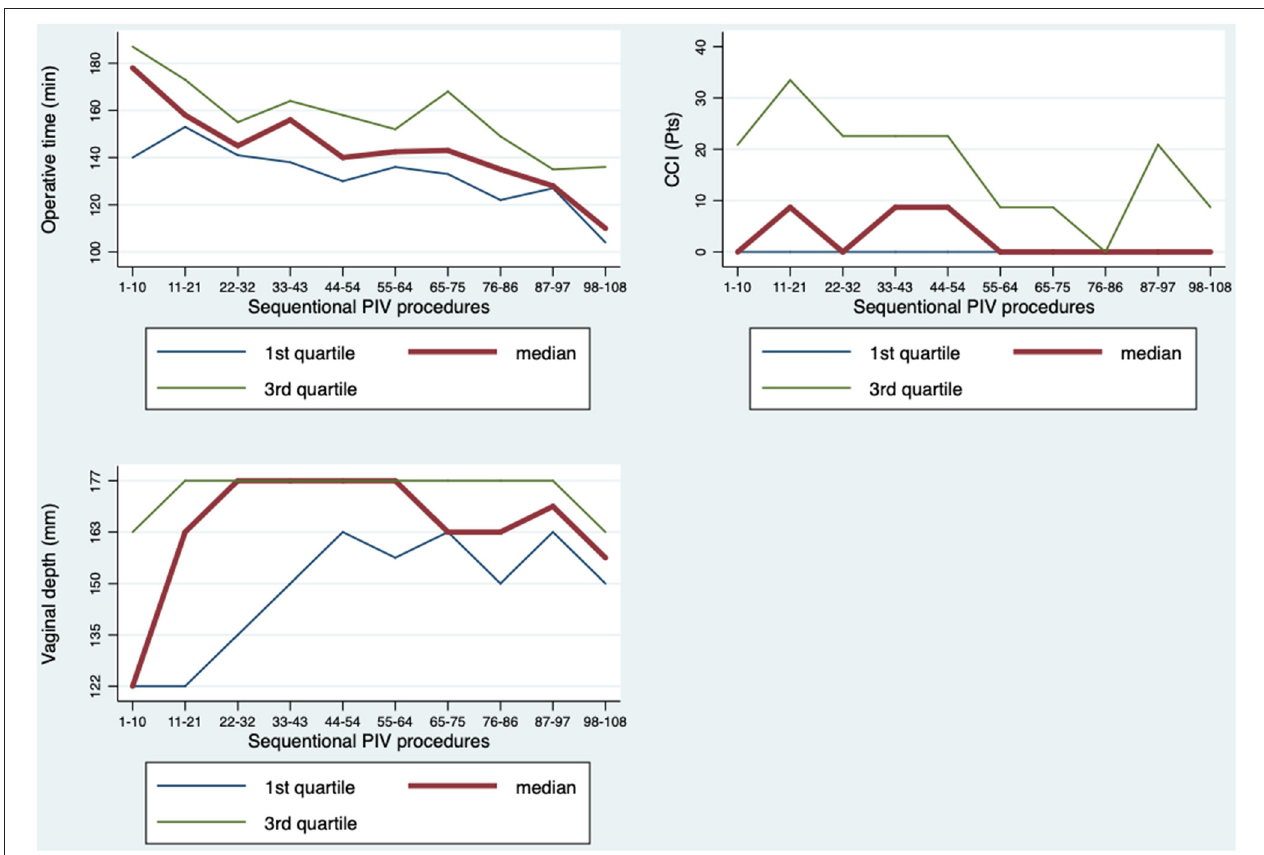
FIGURE 1 | Learning curve analysis based on three factors: operating time, vaginal depth and